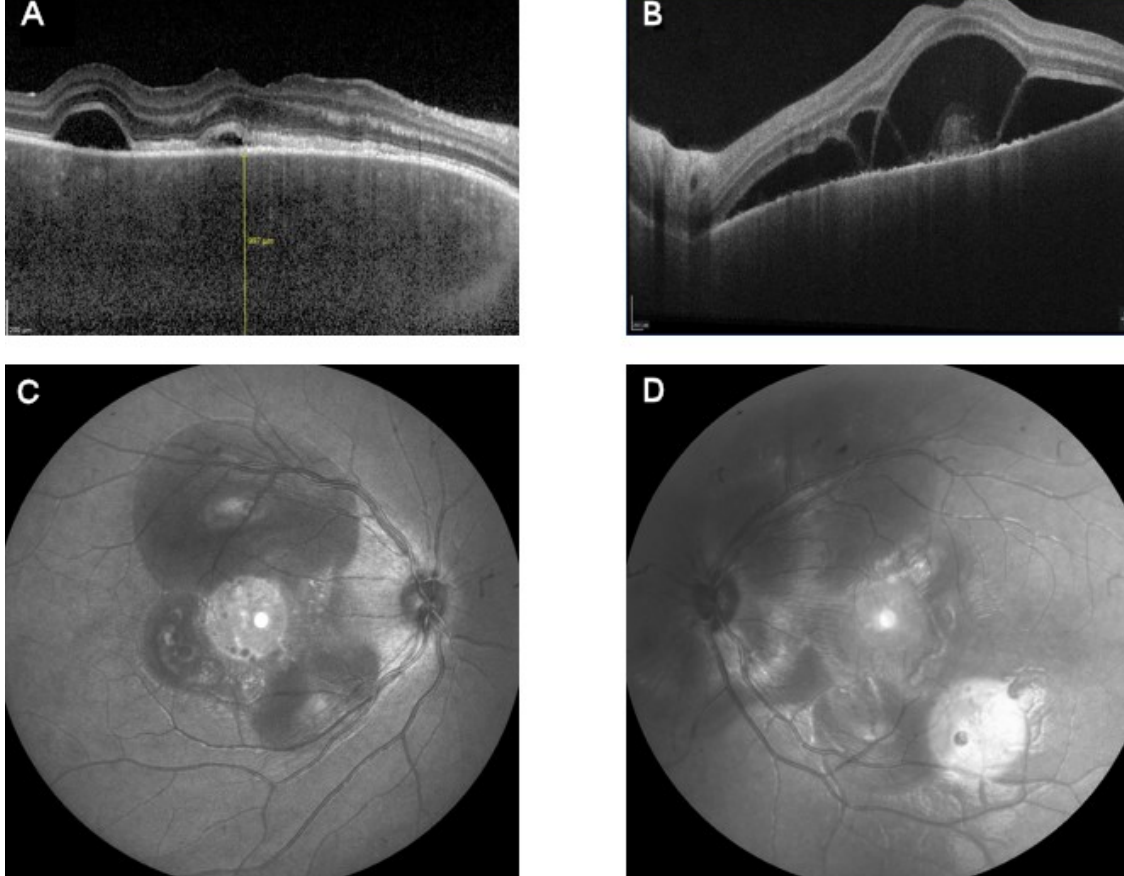
Figure 1: OCT and infrared images show multiple serofibrinous retinal detachments in the right (A, C) and left (B, D) eye and a thickened choroid measured with EDI-OCT (A).